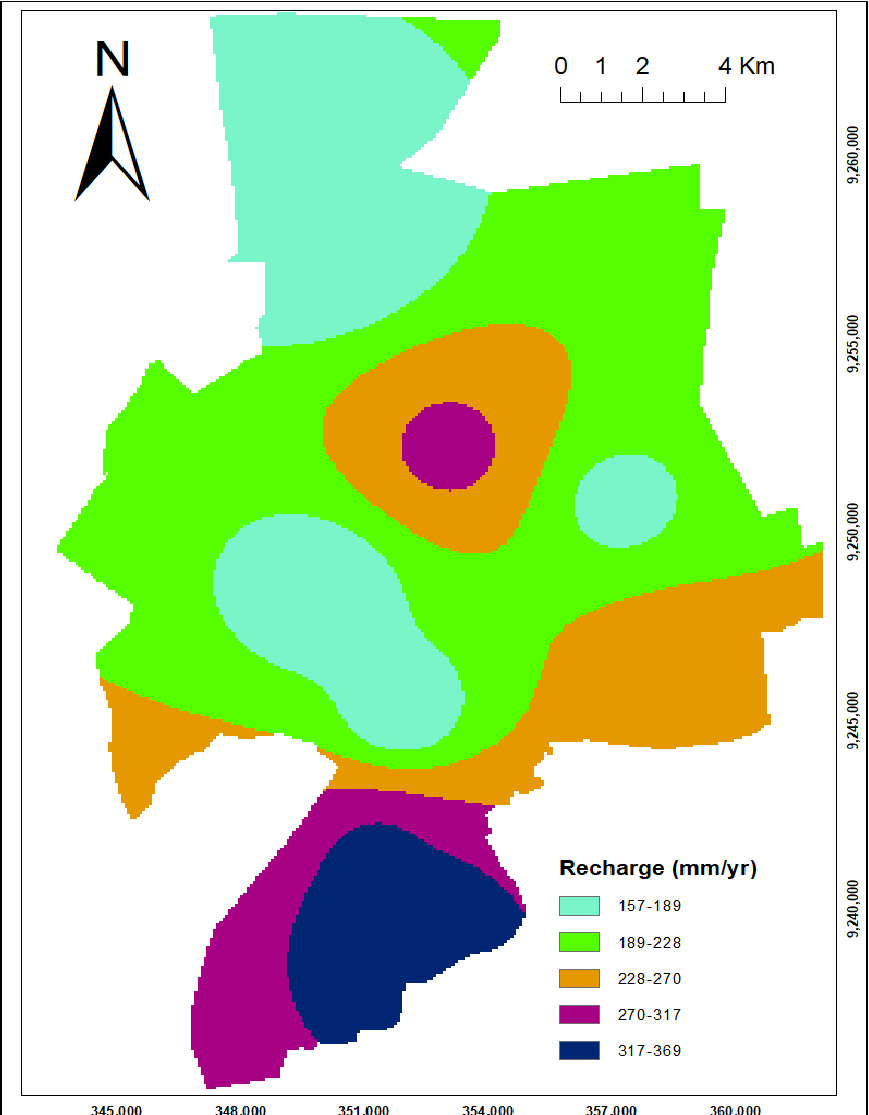
Figure 4. Net recharge map.